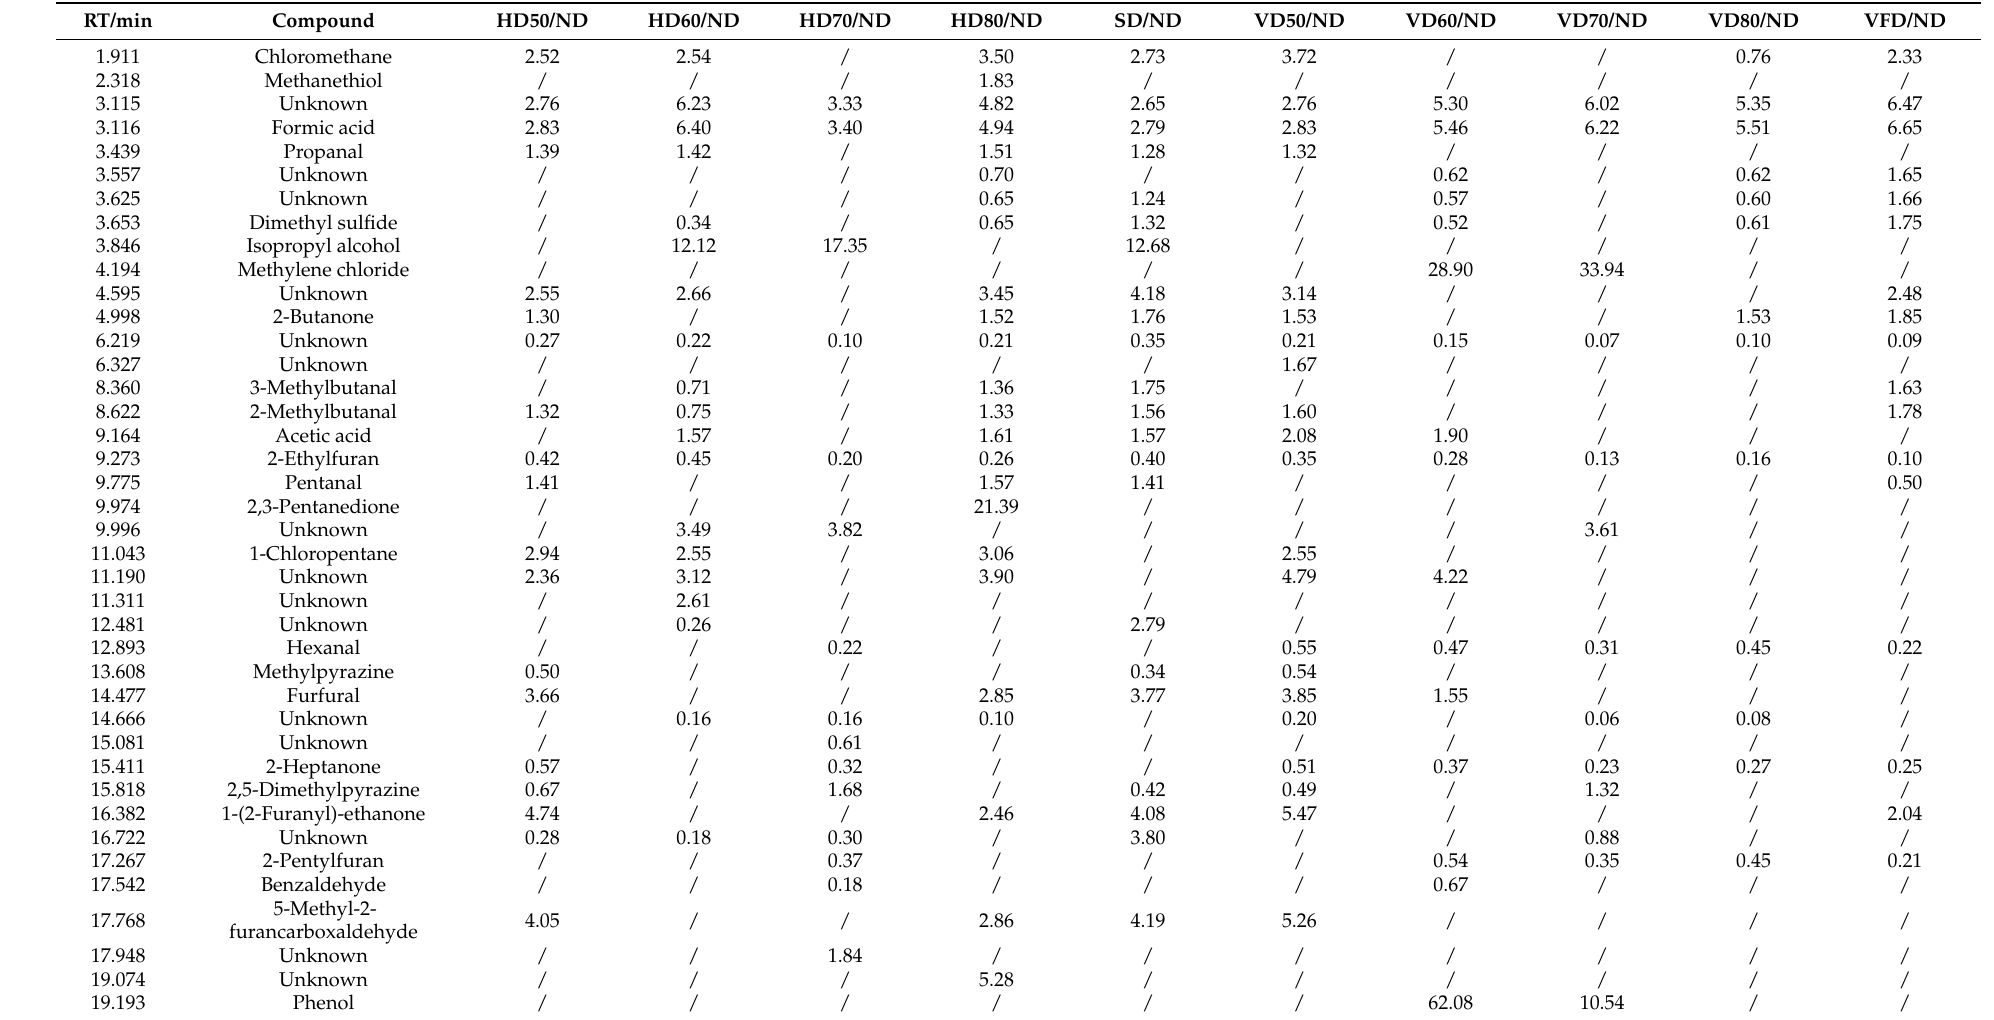
Table 3. The overall view of fold-changes (FC) values between different drying methods and natural drying (ND) 1